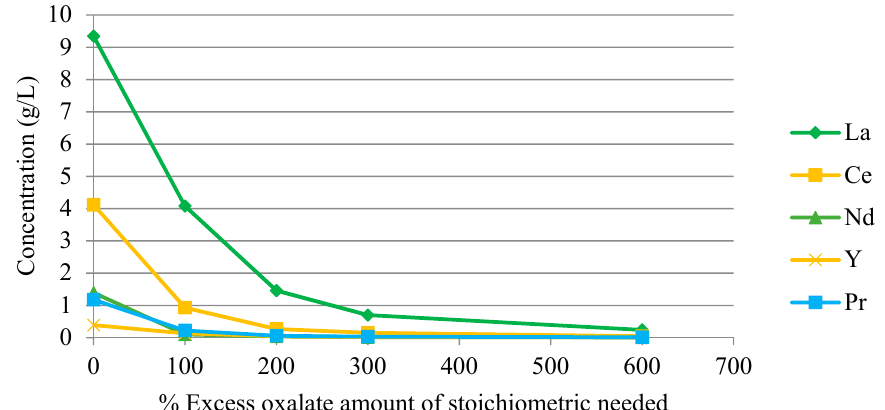
Figure 10. Concentration of La, Ce, Nd, Pr and Y after addition of oxalate.